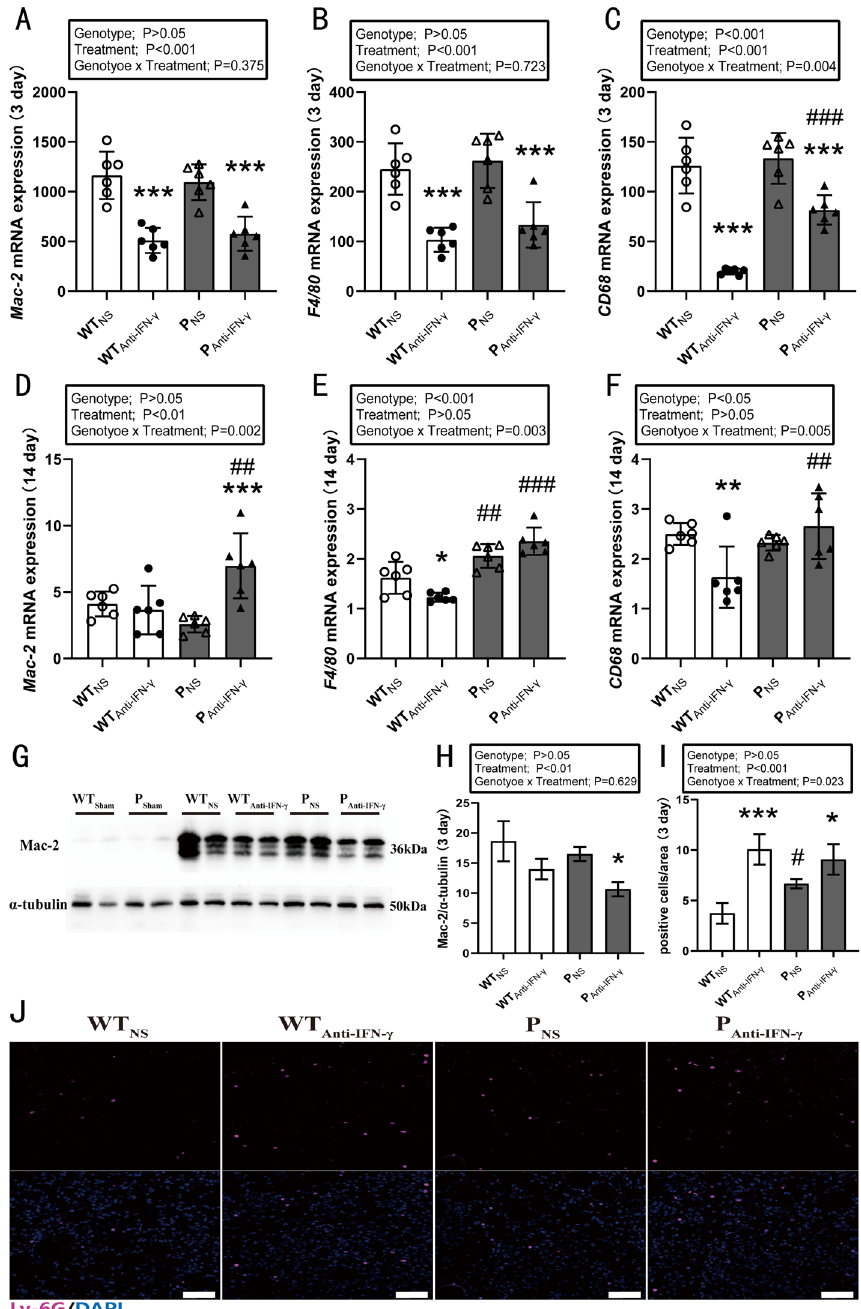
Fig. 3 (See legend on previous